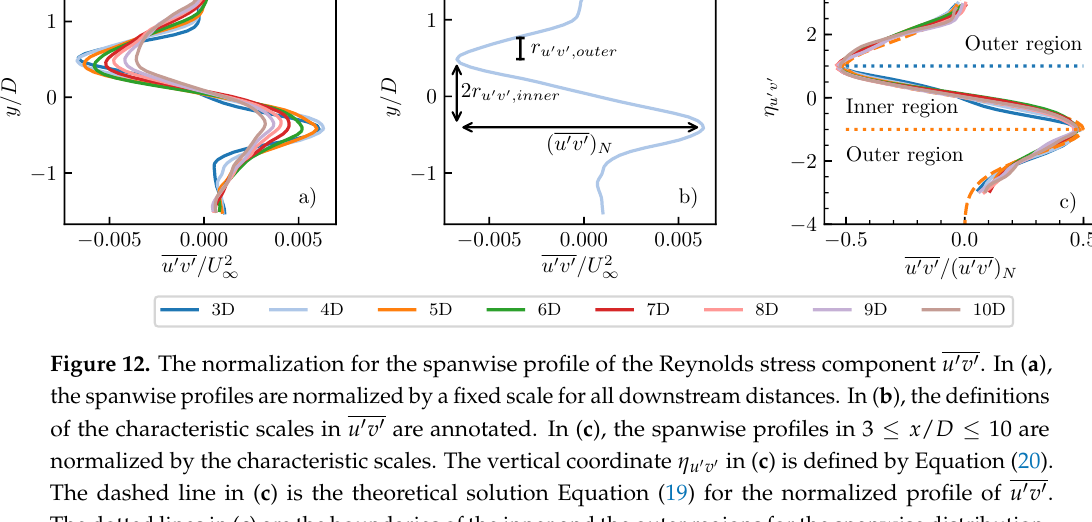
x / D 10 are ≤ ≤ in ( c ) is defined by Equation (20). (cid:48) v (cid:48)